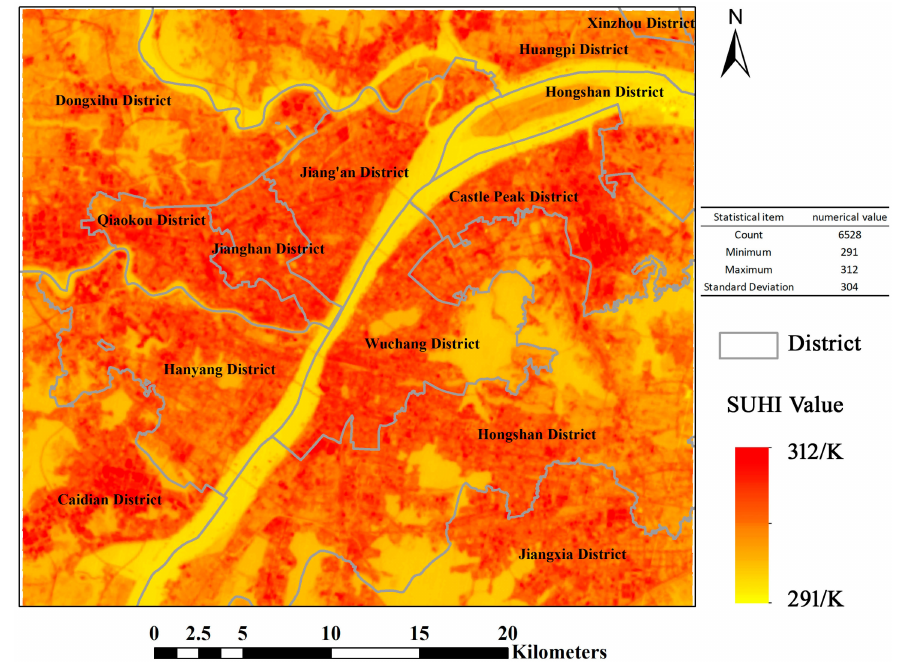
Figure 4. Spatial distribution of the surface urban heat island (SUHI) in